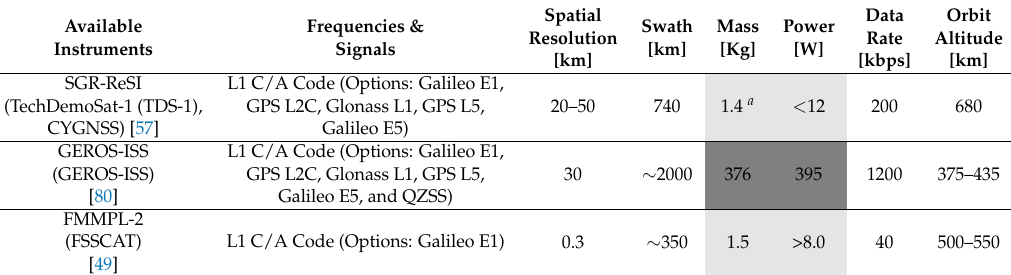
Table A6. Survey of GNSS-R instruments.